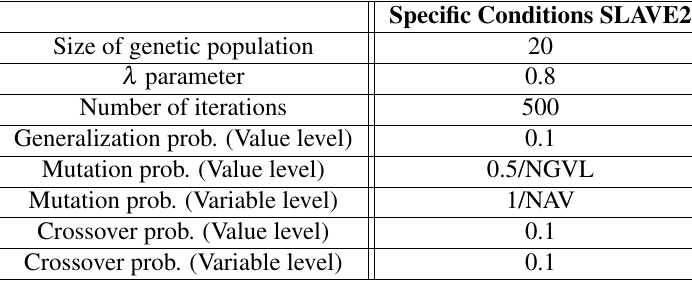
Table 3. Specific conditions for SLAVE2. NGVL means the number of genes in the value level and NAV means the number of antecedent variables.